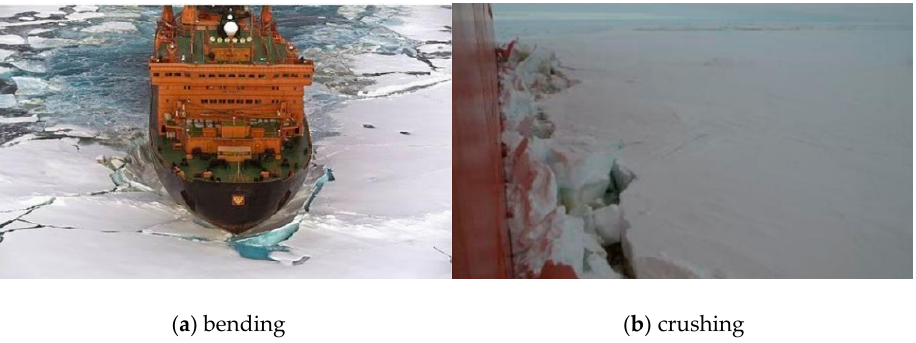
Figure 11. Breaking mode of level ice (www.eworldship.com, accessed on 19 July 2014).